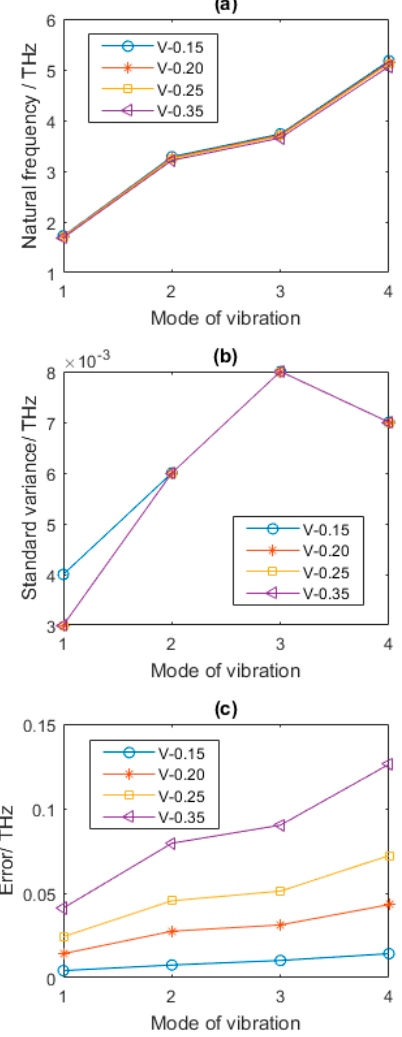
Figure 10. Statistical results of defected graphene sheets with different Poisson ratio ( a – c for mean, standard variance and Error of natural frequency, respectively). V is Poisson ratio.